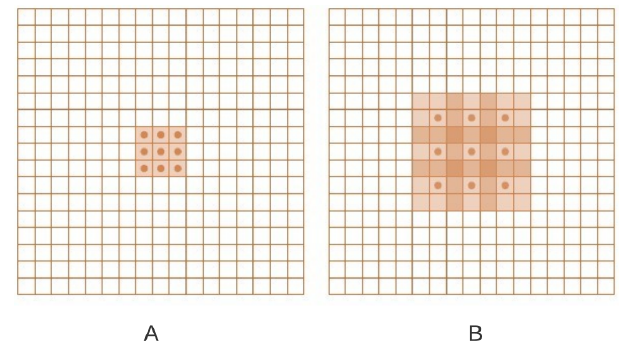
Figure 5. Dilated Convolutions: The figure ( A ) on the left shows the output generated from convolv- ing F1 by a 1-dilated convolution f1; F1, F2 are the larger grid showing original discrete functions and f1, f2 are the green colour discrete filters. Each element in this representation has a receptive field of 3 × 3. Figure ( B ) on the right shows the output generated from F2 convolved with a 2-dilated convolution f2; Each element in this representation has a receptive field of 7 × 7.